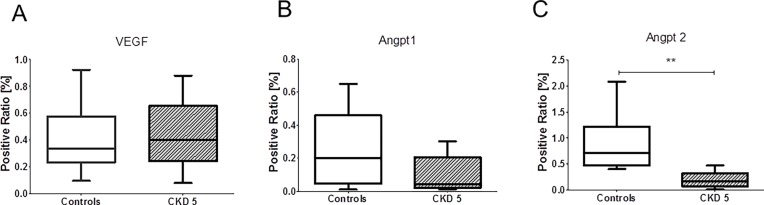
Immunohistochemistry staining.Representative stains for VEGF (A), Angpt1 (B) and Angpt2 (C) in omental biopsies of children with CKD 5 and controls (B,D,F)